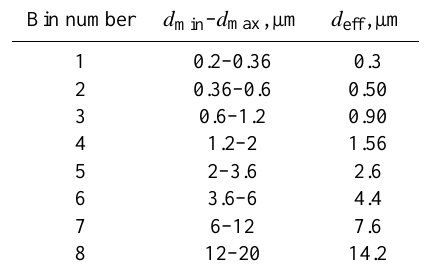
Table 1. Dust size bins introduced in the model. d min and d max are minimum and maximum diameter and d eff is effective diameter for each size bin.